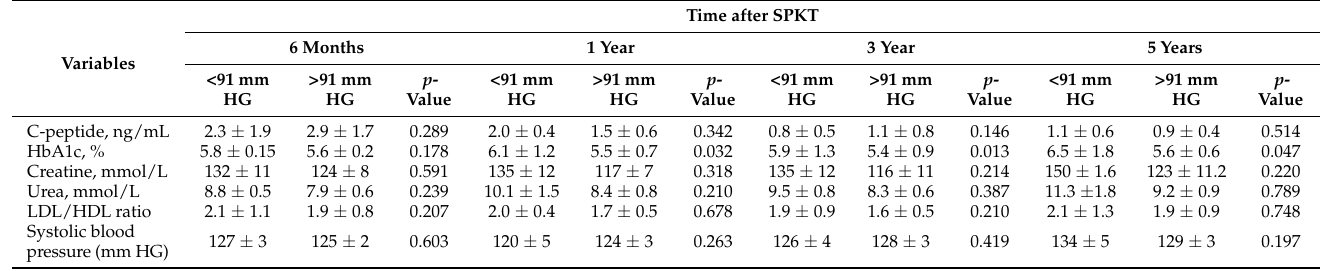
Table 4. Metabolic outcome after simultaneous pancreas–kidney